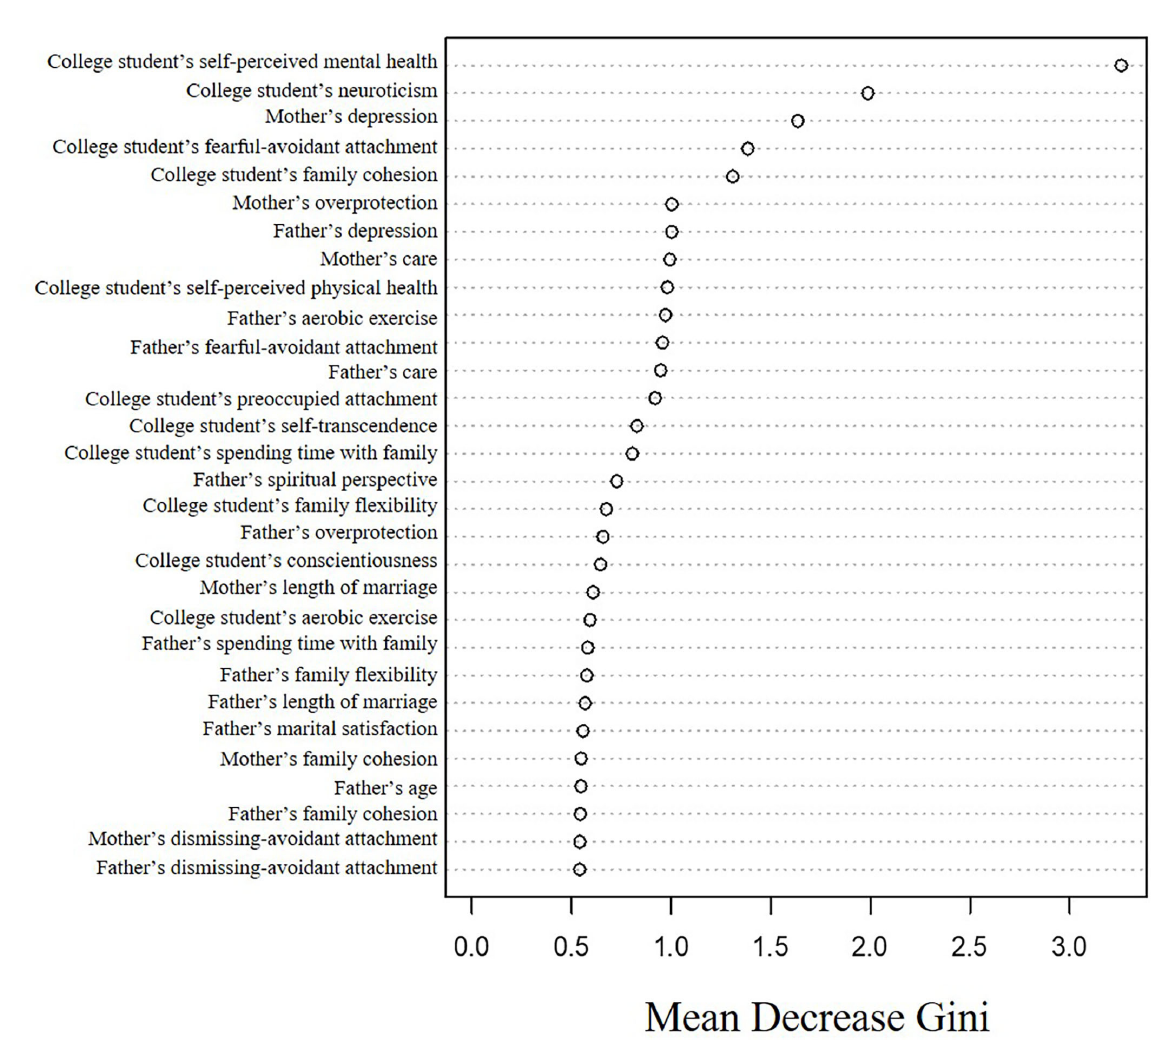
FIGURE1 Predictors of college student’s